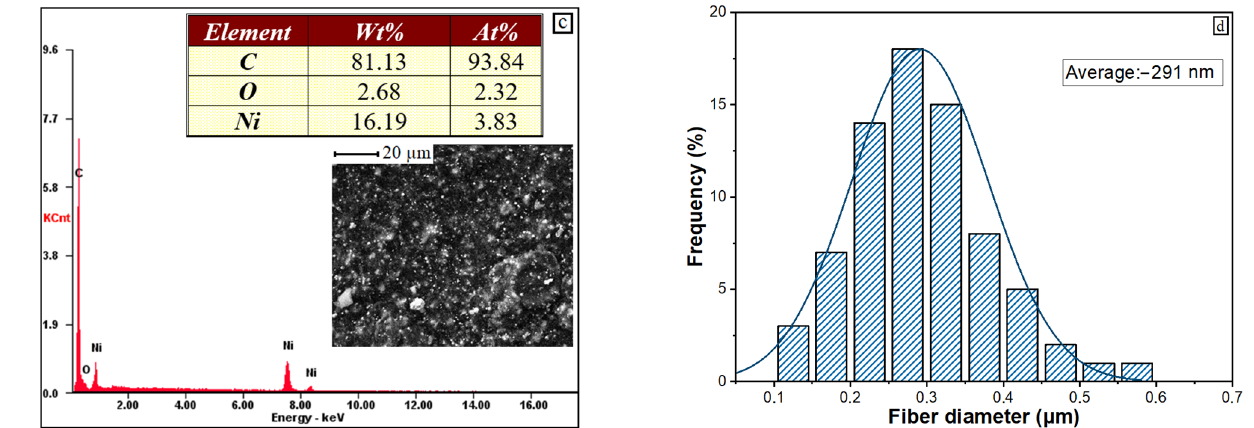
Figure 2. Results of characterization: ( a ) SEM in SE mode image of intermediate PAN/NiO fibers after stabilization at 260 °C, ( b ) SEM in SE mode image of NiO/C fibers from PAN/NiO after stabilization at 260 °C and carbonization at 700 °C; ( c ) EDAX spectrum of NiO/C fibers after carbonization and ( d ) NiO/C fiber diameter distribution after carbonization.